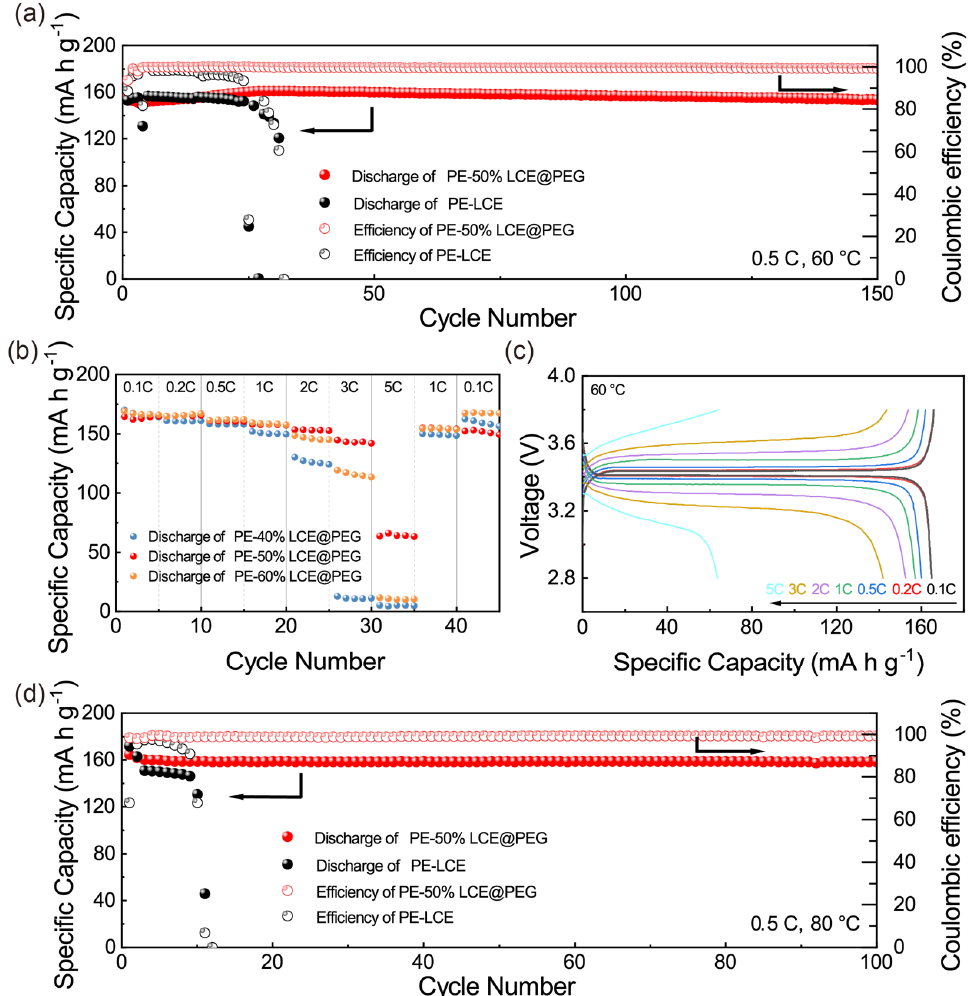
Figure 4. ( a ) Cyclic performances of the LiFePO 4 //Li cells using PE − 50%LCE@PEG and LCE under 0.5 C at 60 °C. ( b ) Rate capability of the LiFePO 4 //Li batteries using PE − x %LCE@PEG ( x = 40, 50, and 60) electrolytes at different rates at 60 °C. ( c ) Charge − discharge voltage profiles of LiFePO 4 //Li battery using PE − 50%LCE@PEG electrolyte at different rate under 60 °C. ( d ) Cyclic performances of the LiFePO 4 //Li batteries using PE − 50%LCE@PEG and LCE electrolyte under 0.5 C at 80 °C. Furthermore, a series of flexibility and safety tests were performed on the LiFePO 4 / PE − 50%LCE@PEG/Li pouch cells. As shown in Figure 5, the pouch batteries with PE − 50%LCE@PEG can continuously light up the yellow LED in the flat state, folded state, several fold and even cut, which displays the good reliability and safety of PE − 50%LCE@PEG for flexible solid − state lithium